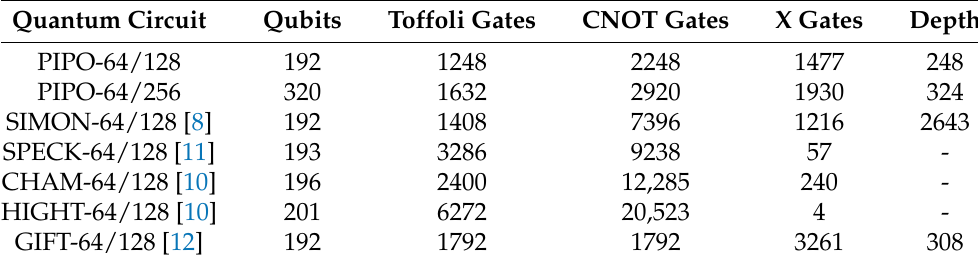
Table 2. Quantum resources required for PIPO quantum circuit implementation and comparison with other block